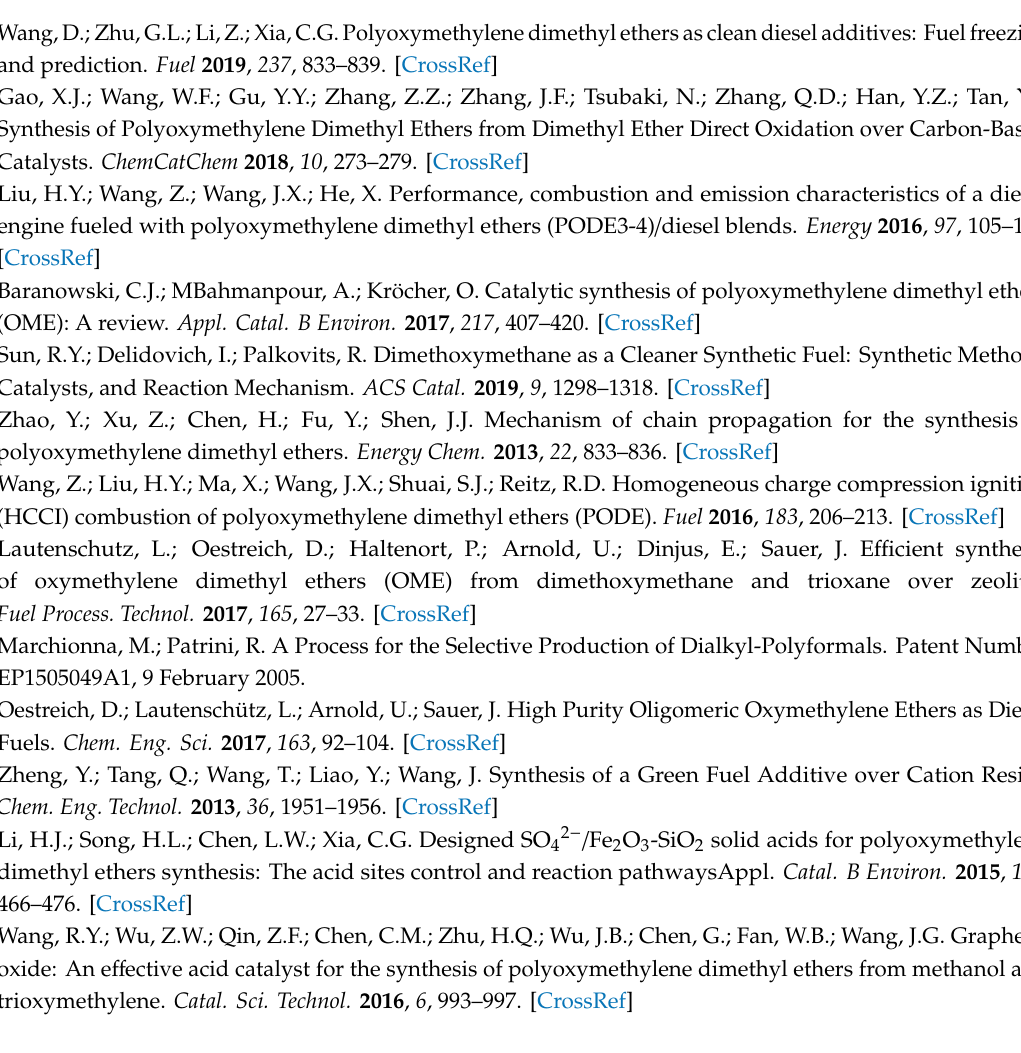
Figure S1: The XRD patterns of various zeolite catalysts; Figure S2: SEM images of various zeolite catalysts; Figure S3: The Py-IR profiles of each zeolite at di ff erent temperatures; Figure S4: E ff ect of the feed DMM / TOM molar ratio on the reactant conversion and PODE 2 − 8 selectivity over HZSM-5; Figure S5: E ff ect of the reaction time on the reactant conversion and PODE 2 − 8 selectivity over HZSM-5; Figure S6: E ff ect of the HZSM-5 catalyst amount on the reactant conversion and product distribution over HZSM-5; Figure S7: SEM images of ZSM-5 zeolites with di ff erent particle sizes (I) and its catalytic performance for the synthesis of PODE n (II); Figure S8: DMM disproportionation over H-ZSM-5 zeolites with a Si / Al ratio of 17 at di ff erent temperatures; Figure S9: Isosurface plots of the reduced density gradient (s = 0.500 a.u.) for the coadsorption of DMM and TOM in beta (a) and MOR (b); Figure S10: TOM conversion and product selectivity for TOM decomposition over the ZSM-5 and USY zeolites at 120 ◦ C; Figure S11: Two typical GC chromatograms from Shimadzu GC-2014C and Shimadzu GC-14B; Table S1: Adsorption energy of DMM, TOM, and their combination in SUZ-4, beta, and MOR; Table S2: Comparison of HZSM-5(Si / Al = 17) and some recently reported catalysts for the synthesis of PODE n